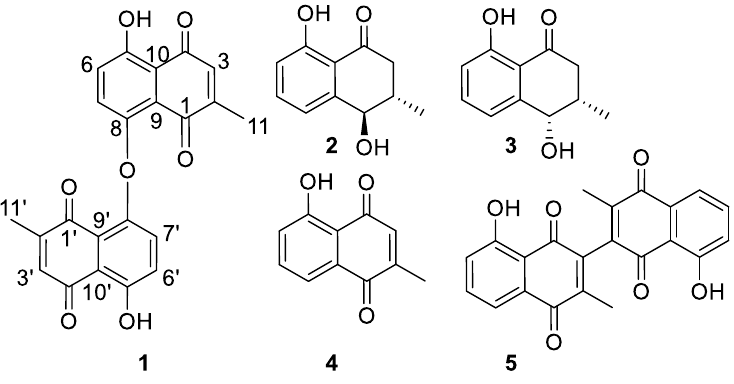
Figure 1. Compounds 1 – 5 isolated from D . shimbaensis Figure1. Compounds 1 – 5 isolated from D . shimbaensis .